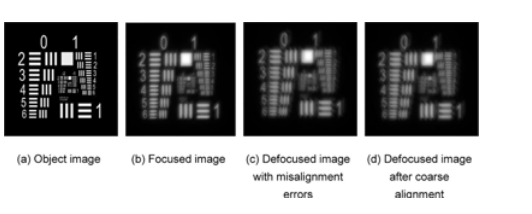
Fig 4. Relevant object images of the resolution test panel experiment.